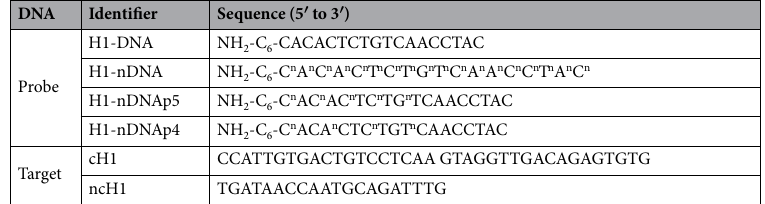
Table 1. Sequences of regular DNA, neutralized DNA, neutralized chimeric DNA, and target DNA molecules. The superscript “n” denotes the neutralized nucleotides with phosphate-methylated phosphate